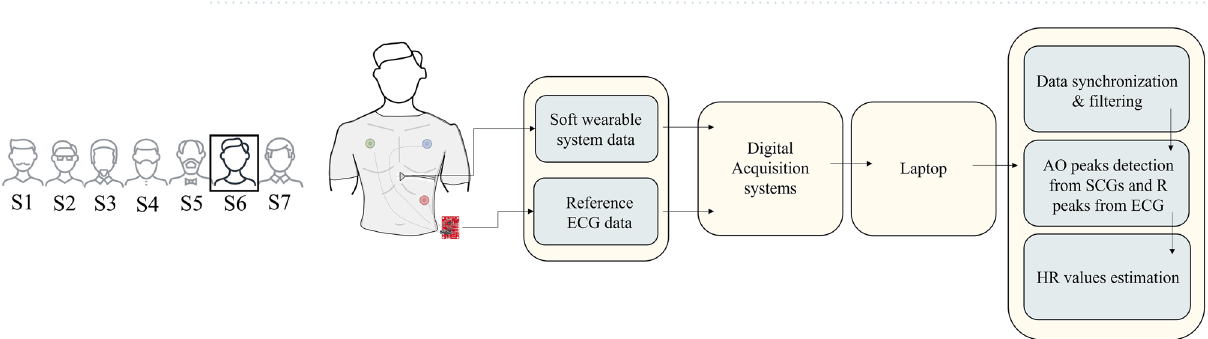
Figure 4. A block representation of the main steps of the data collection and processing to estimate